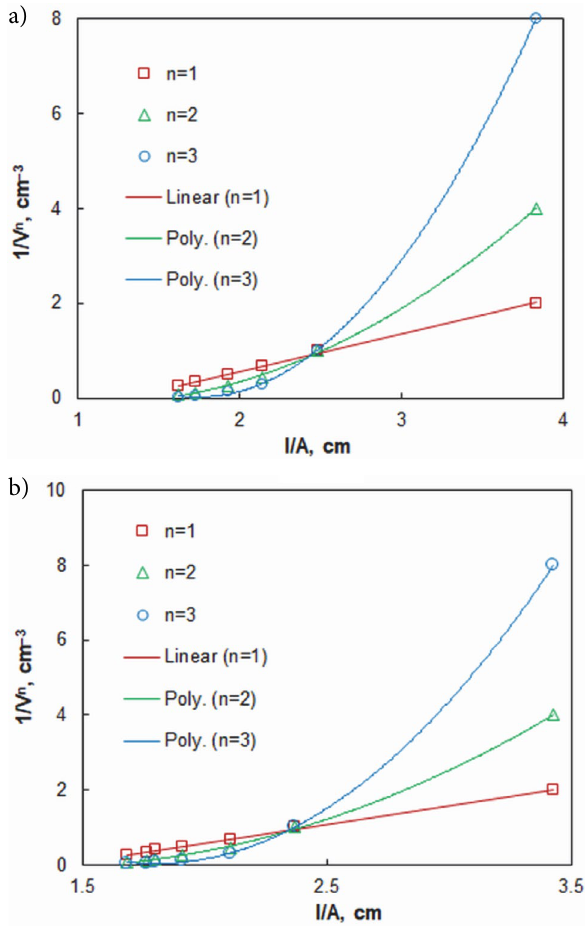
Figure 4. Determination of the TAO/V V ( a ) and A336/V V ( b ) molar ratios by the straight-line method of Asmus. The experimental con- ditions are given in Fig. 3.